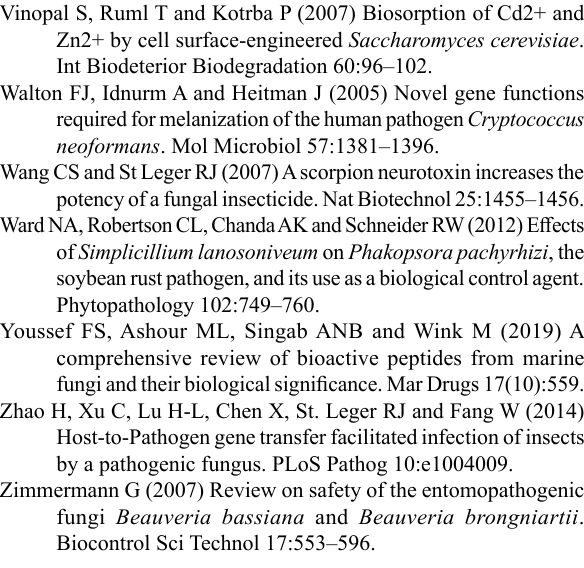
Figure S1 ‒ pPZP201BK::SUR::gpdA::Kat::TrpC plasmid map.